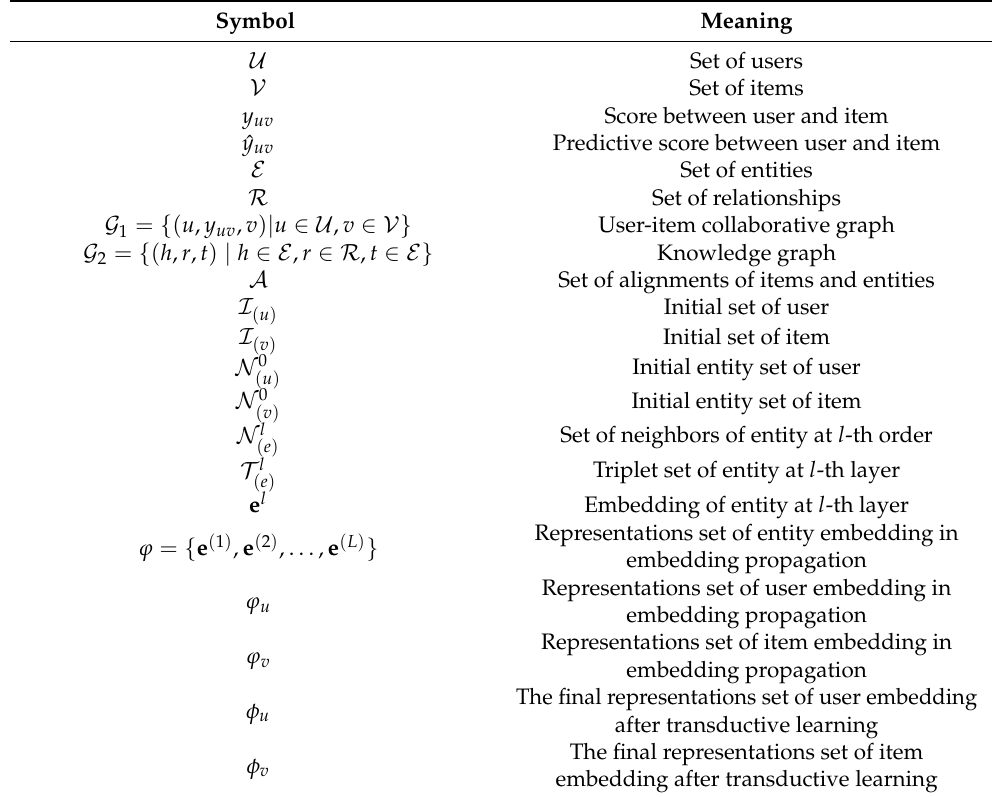
Table 1. List of symbols. Symbol Meaning U Set of users